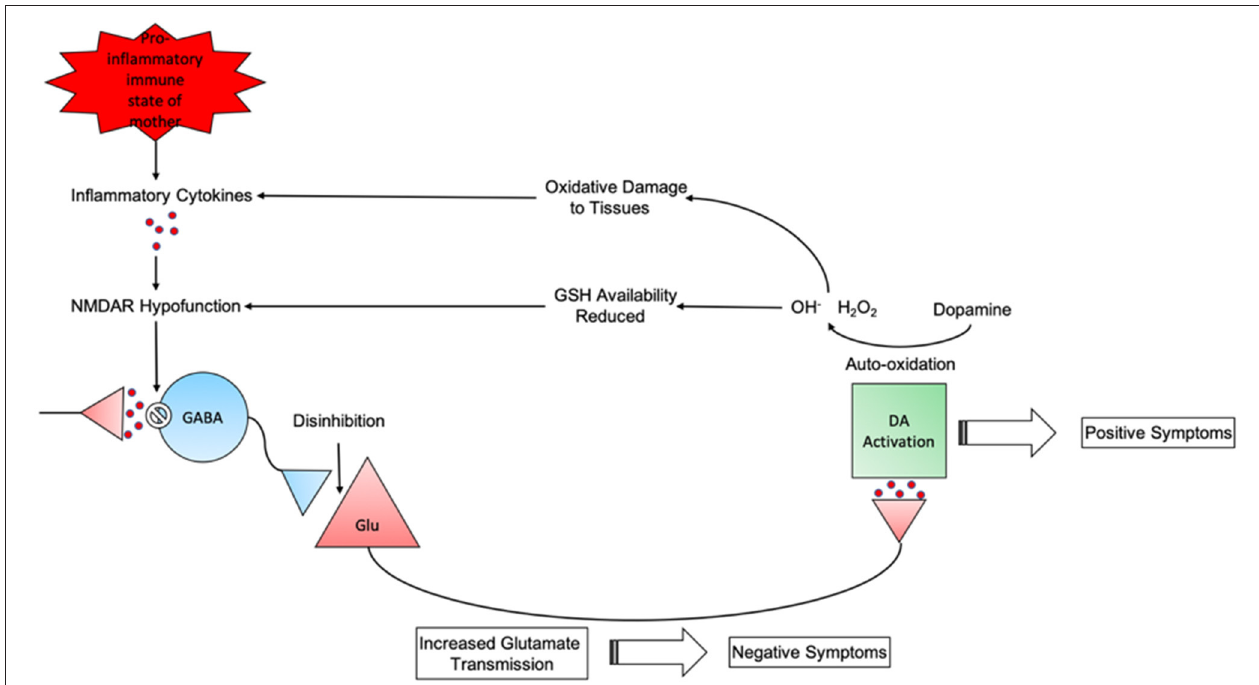
FIGURE 2 | The cyclical nature of schizophrenia progression from maternal pro-inflammatory state to behavioural